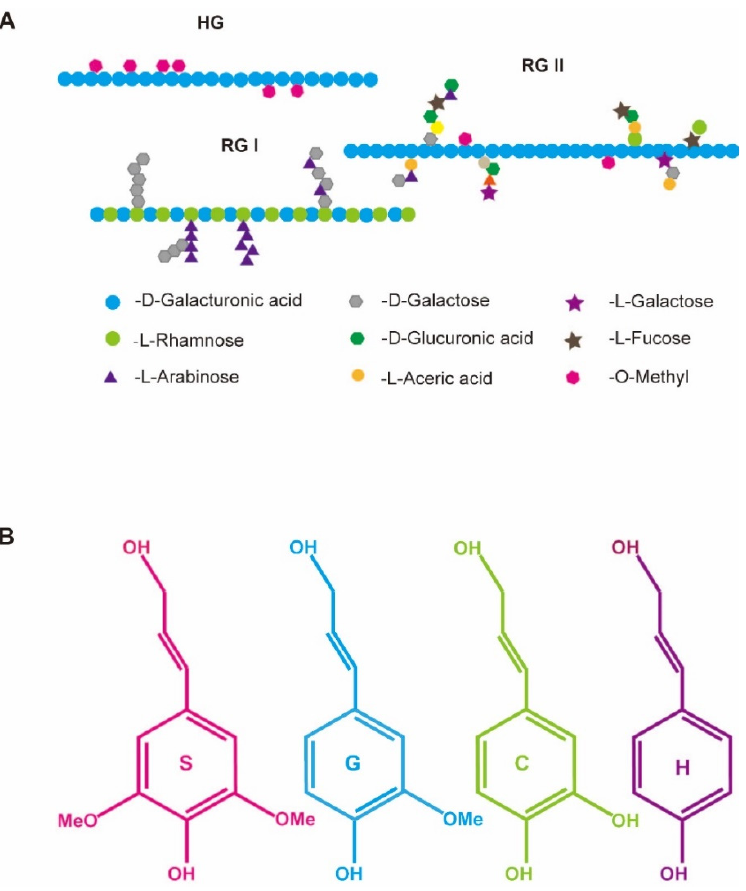
Figure 2. ( A ) Schematic structure of the three major pectic polysaccharides including homogalac- turonan (HG), rhamnogalacturonan I (RG I) and rhamnogalacturonan II (RG II). HG is unbranched linear chain composed of 1, 4-linked α -D-galactosyluronic acid residues which can be methylesteri- fied. RG I is branched pectic polysaccharides with backbone composed of repeating disaccharide ( α -1,4-d-GalA- α -1,2-l-Rha) in which rhamnosyl residues serve as attachment sites for various side chains mainly including galactosyl and arabinosyl residues. RG II has the same backbone as HG and is highly branched with the most complex side chains containing 12 different glycosyl residues linked by over 20 different glycosyl linkages. ( B ) Chemical structure of the four representative monomeric subunits of lignin, including p-hydroxyphenyl (H), guaiacyl (G) and syringyl (S) units.